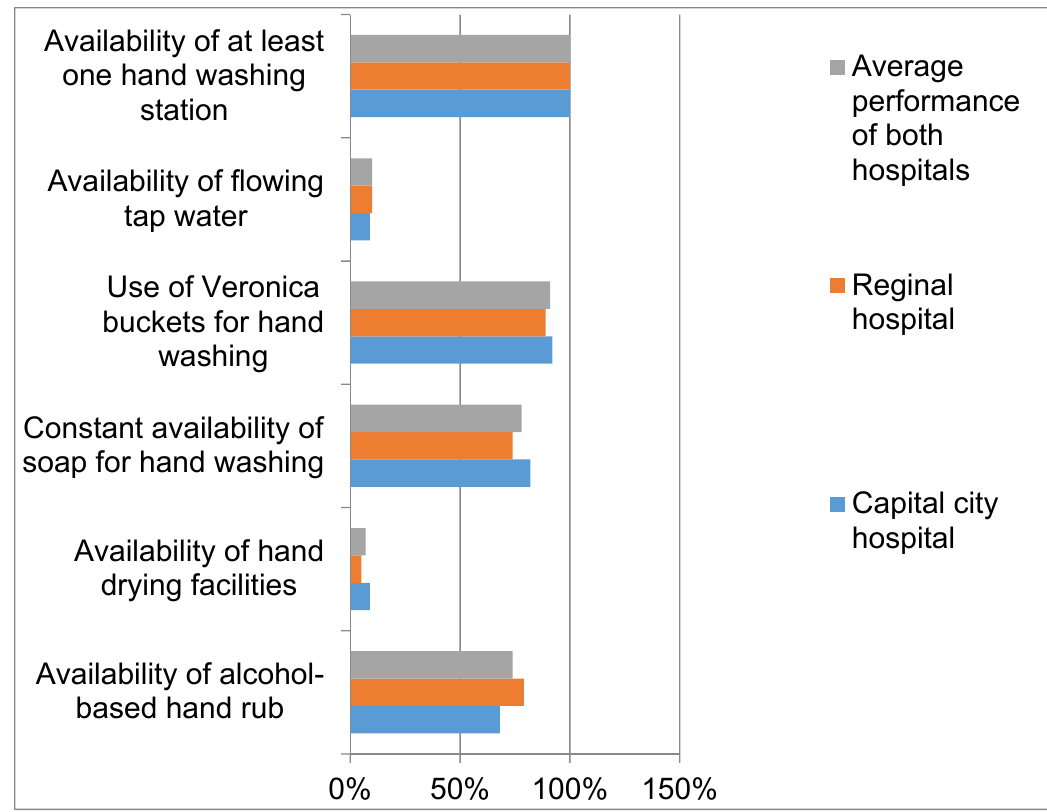
Figure 1. Hand hygiene facilities in the units/wards/departments of two hospitals in Sierra Leone. There were relatively more hand-washing stations in triage, obstetric wards, and nursing units for high-risk infectious diseases. In contrast to the Intensive Care Unit (ICU) of the hospital in the Capital City which has 5 hand washing stations, the ICU in the regional hospital had only one washing station. Except for the triage and laboratory of the Capital City hospital and the pharmacy and obstetrics units of the regional hospital, the hand washing stations of all other units, wards, or departments used hand-operated (Veronica) buckets. No unit/ward/department uses multiple used towels, and only the maternity unit of the regional hospital and the infectious disease units in either hospital used disposable paper towels for hand drying as shown in Table 2.